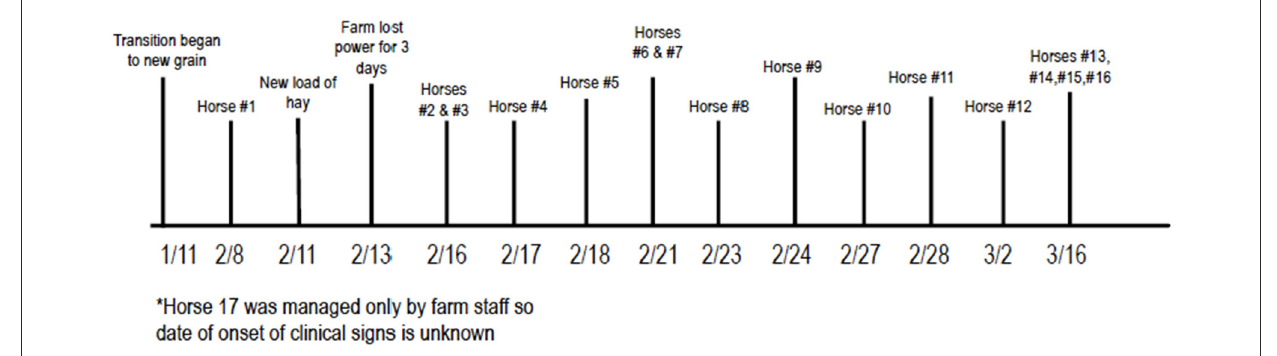
FIGURE2 Chronologic order of events in outbreak. *Horse 17 was managed only by farm staff so date of onset of clinical signs is unknown.